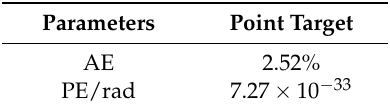
Table 4. AE and PE between the original image and the reconstructed image.